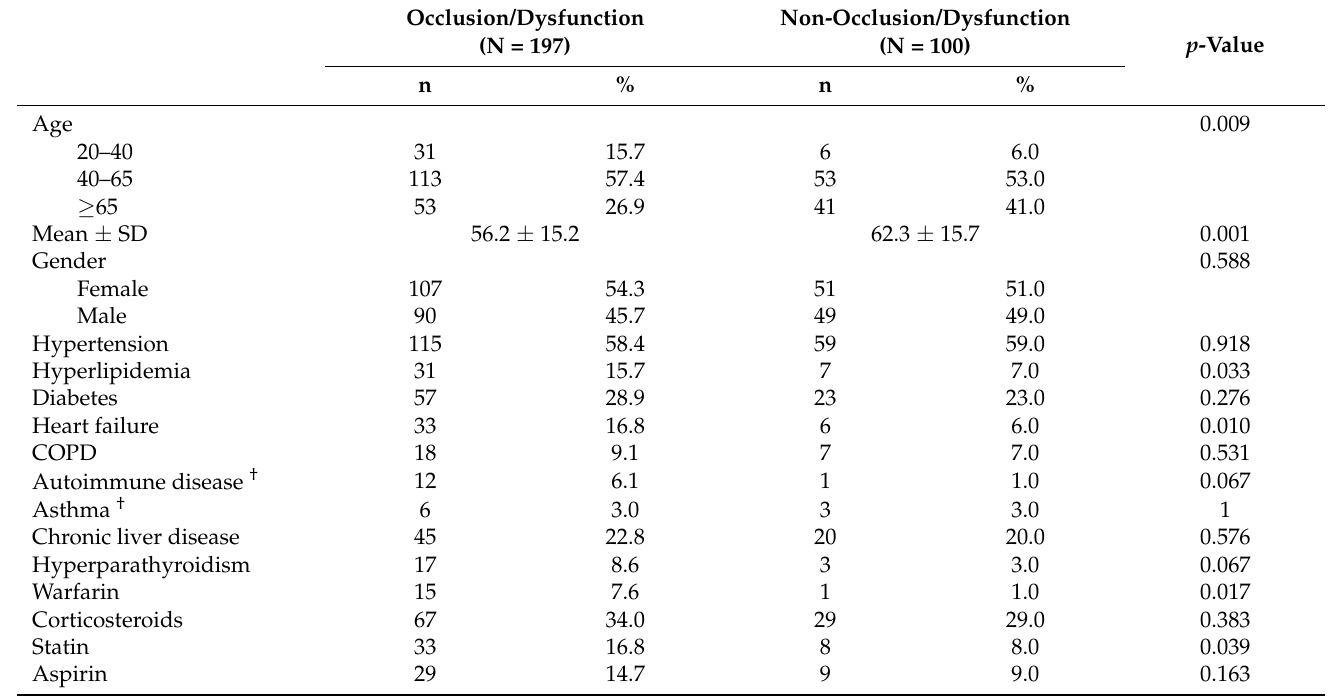
Table 1. Demographic characteristics of the